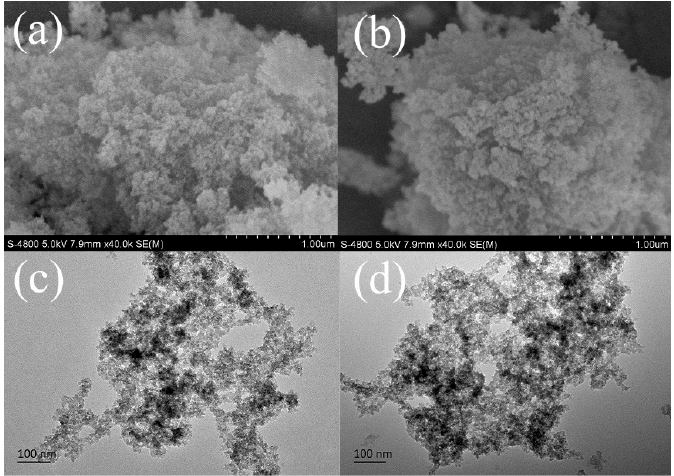
Figure 2. Scanning electron microscope (SEM) images of ( a ) PQPBr and ( b ) PQPBr ‐ 2OH; Transmission electron microscopy (TEM) image of ( c ) PQPBr and ( d ) PQPBr ‐ 2OH.